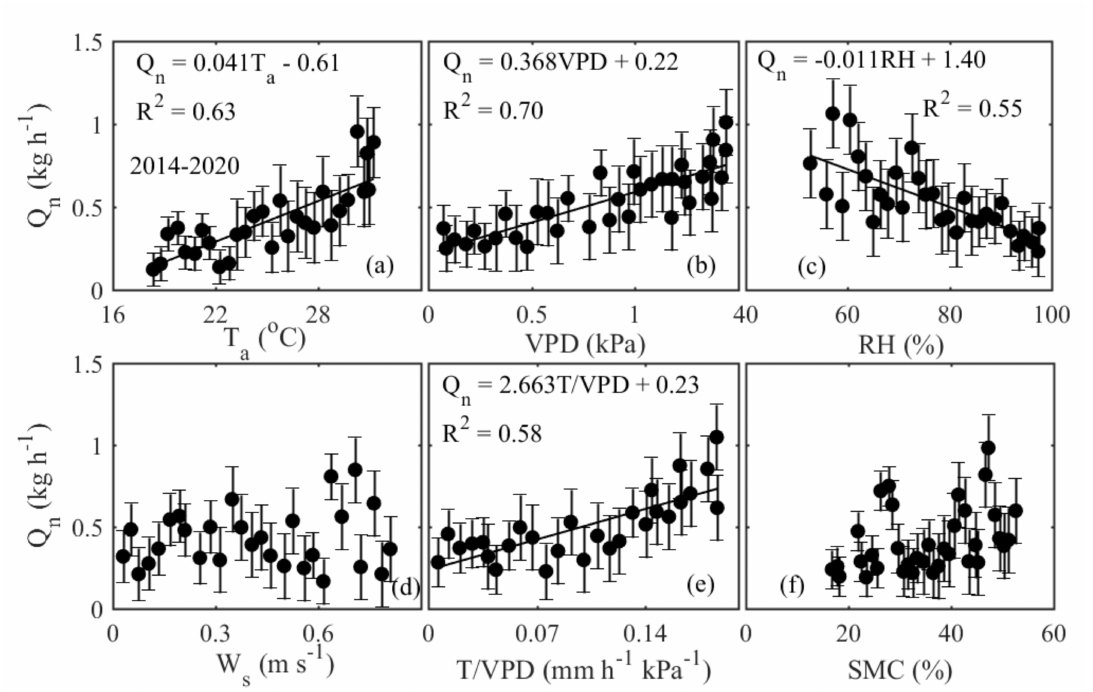
Figure 3. Relationship between nocturnal means of sap flow (Q n ) vs. site micro-hydrometeorological parameters, i.e., ( a ) air temperature (T a ), ( b ) vapor pressure deficit (VPD), ( c ) relative humidity (RH), ( d ) wind speed (W s ), ( e ) canopy conductance (T/VPD), and ( f ) soil moisture content (SMC) during the growing seasons of 2014–2020. Data points represent the binned averages of pooled data from 1 May to 31 October for seven years at every 0.5 ◦ C, 0.05 kPa, 1.5%, 0.03 m s − 1 , 0.008 mm h − 1 kPa − 1 , and 1% intervals of T a , VPD, RH, W s , T/VPD, and SMC, respectively. Bars denote standard